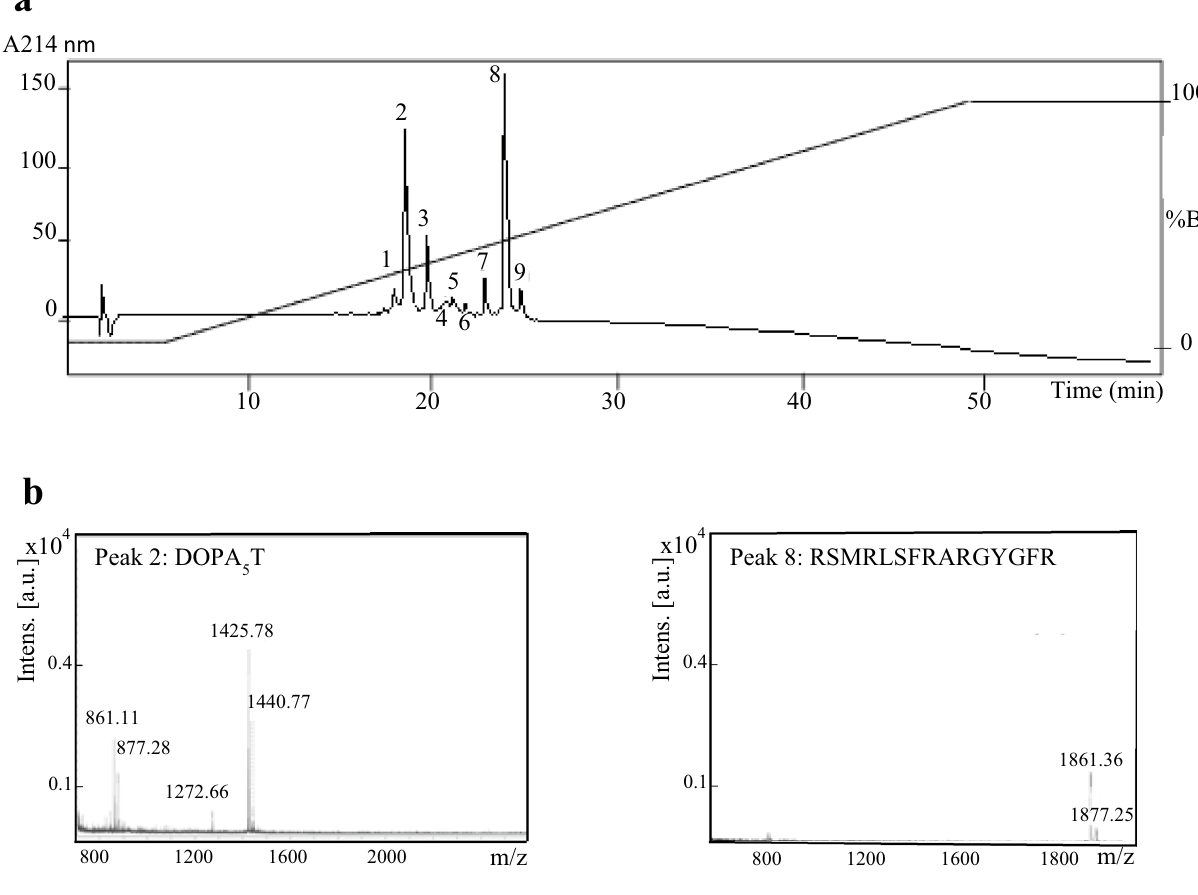
Figure 6. RP-HPLC and identification of the fragments obtained after incubation of DOPA 5 T-Ctl with the endoprotease Glu-C. ( a ) Chromatogram of the reverse –phase HPLC; gradient of elution is reported on the chromatogram (%B). ( b ) Maldi-Tof mass spectrometry of peaks 2 and 8 of the chromatogram. The Maldi-Tof mass spectrometry of minor peaks are reported in Supplementary Fig.